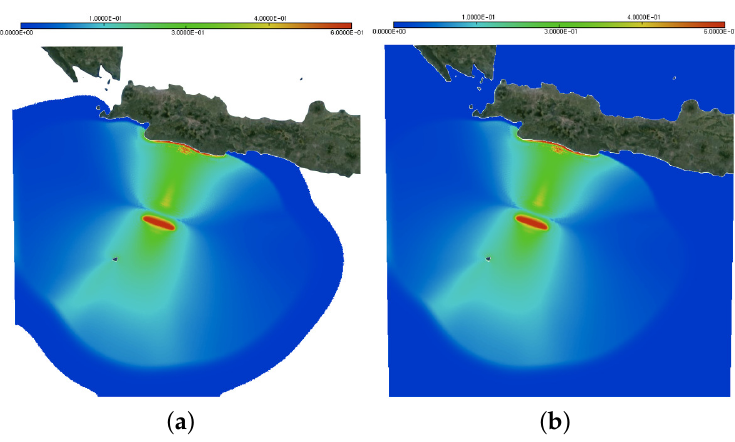
Figure 18. Passive generation: comparison between the maximum of the solution at t = 1750 s, with the domain adaptivity method (left panel) and with the full one (right panel).